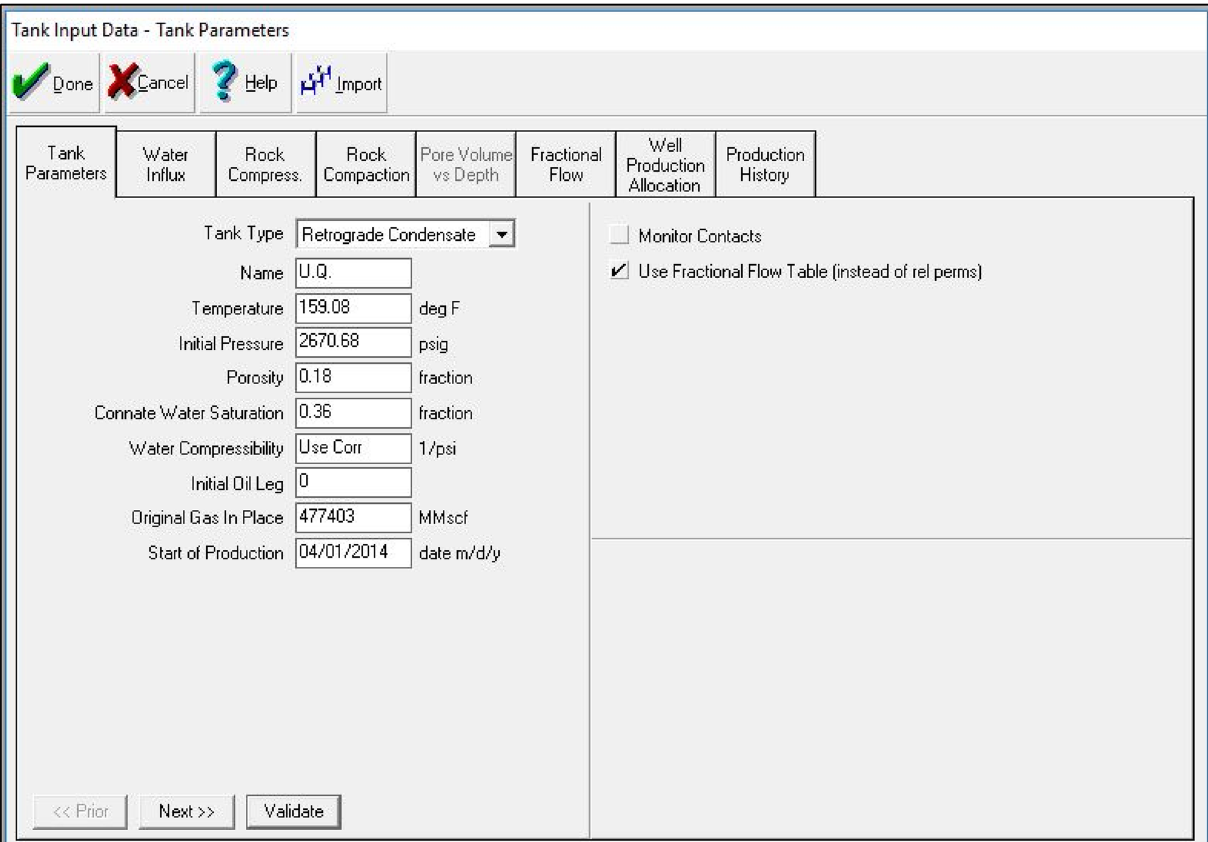
Fig. 9 Material balance model: reservoir